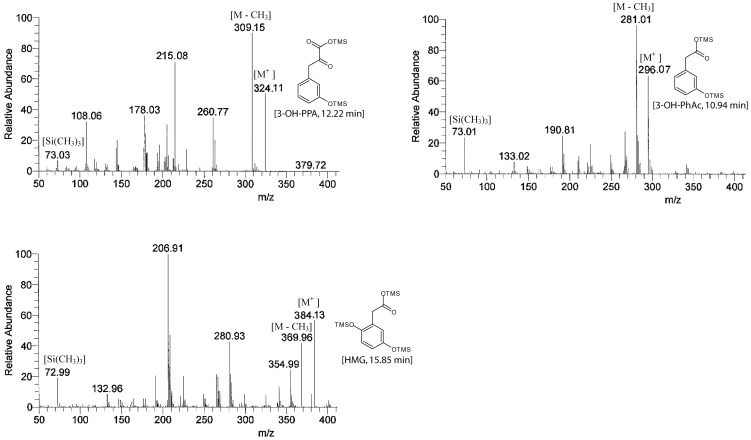
Mass fragmentation patterns of m-tyrosine intermediates including 3-OH-PPA, 3-OH-PhAc, and HMG analyzed by GC-MS.